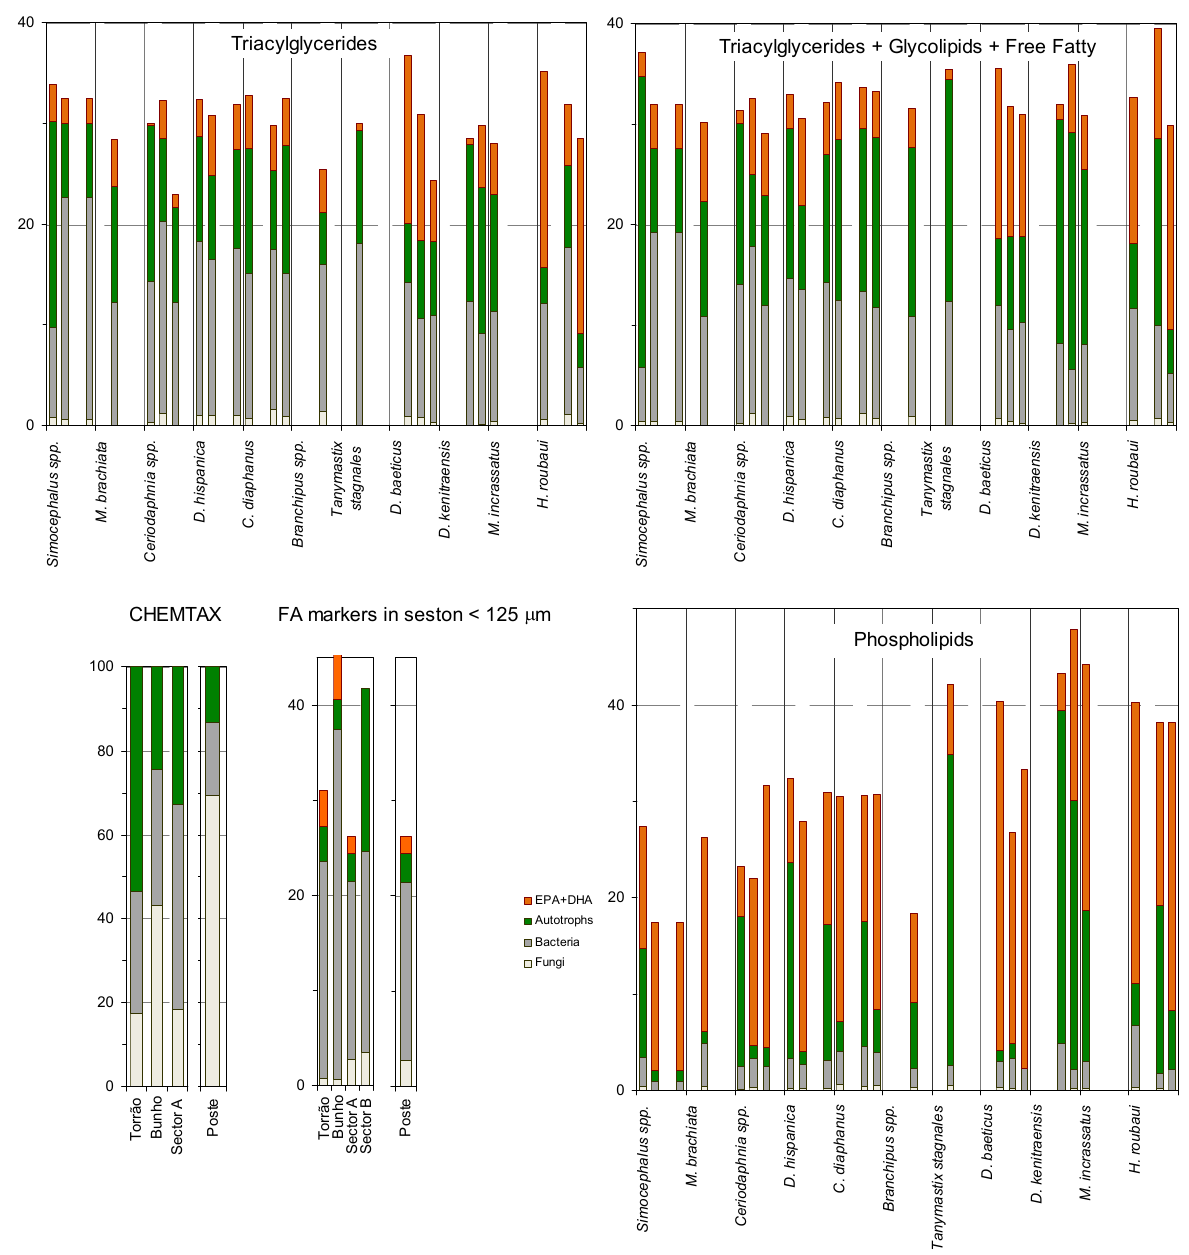
Figure 5. Relative abundance of the groups of autotrophs, bacteria and fungi in pond seston calculated by CHEMTAX, and calculated from the sum of FA markers of each group (lower left hand side panels). The content of the same FA markers in zooplankton was calculated in the neutral lipids of zooplankton (upper left panel), in the sum of their neutral lipids plus acetone mobile (glycolipids) and free fatty acids (upper right panel) and in zooplankton phospholipids (lower right panel). FA marker of fungi is 16:1 ω 5, FA markers for bacteria are 15:0, ante- and iso - FA, hydroxy substituted FA, cyclopropyl saturated FA and 18:1 ω 8, and FA markers of autotrophs are C16 PUFA and C18 PUFA. Tanymastix stagnales was present only in pond “Poste”. The other zooplankton were collected in a set of 4 ponds and are depicted in the order (from left to right) Torrao, Bunho, A6 and in ponds B20-B27. Please note the different YY axis scales.